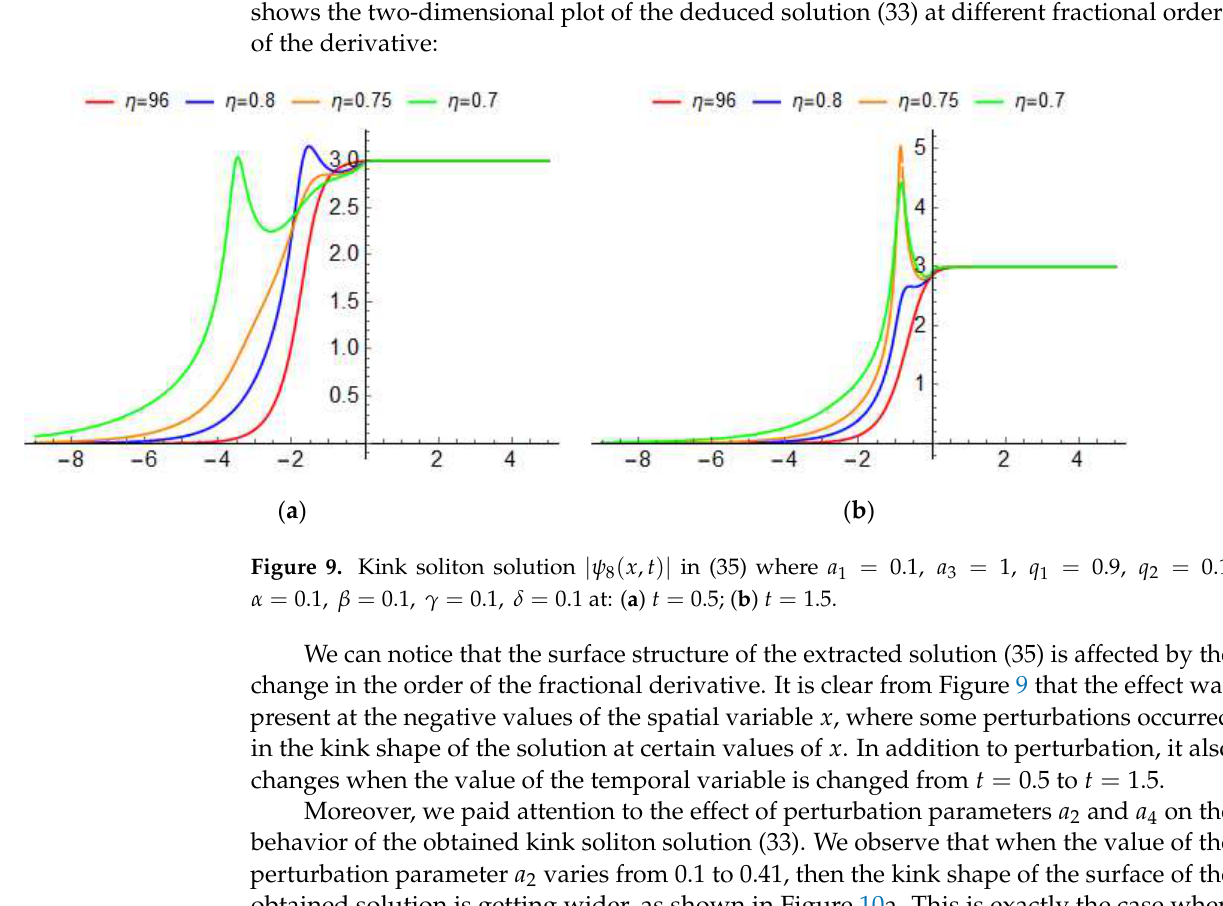
Figure 8. Kink soliton solution (cid:3627) 𝜓 0.1, 𝛽 = 0.1, 𝛾 = 0.1, 𝛿 = 3 : ( a ) integer derivative order 𝜂 = 1 ; ( b ) fractional derivative order 𝜂 = 0.82 .